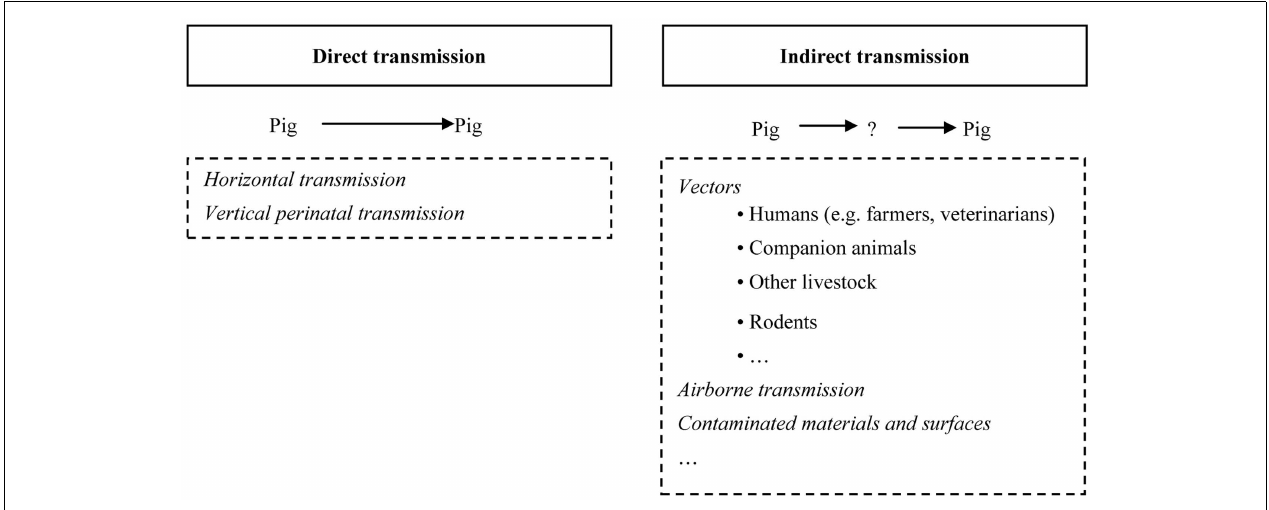
FIGURE 1 | Schematic overview of the potential transmission routes of MRSA between